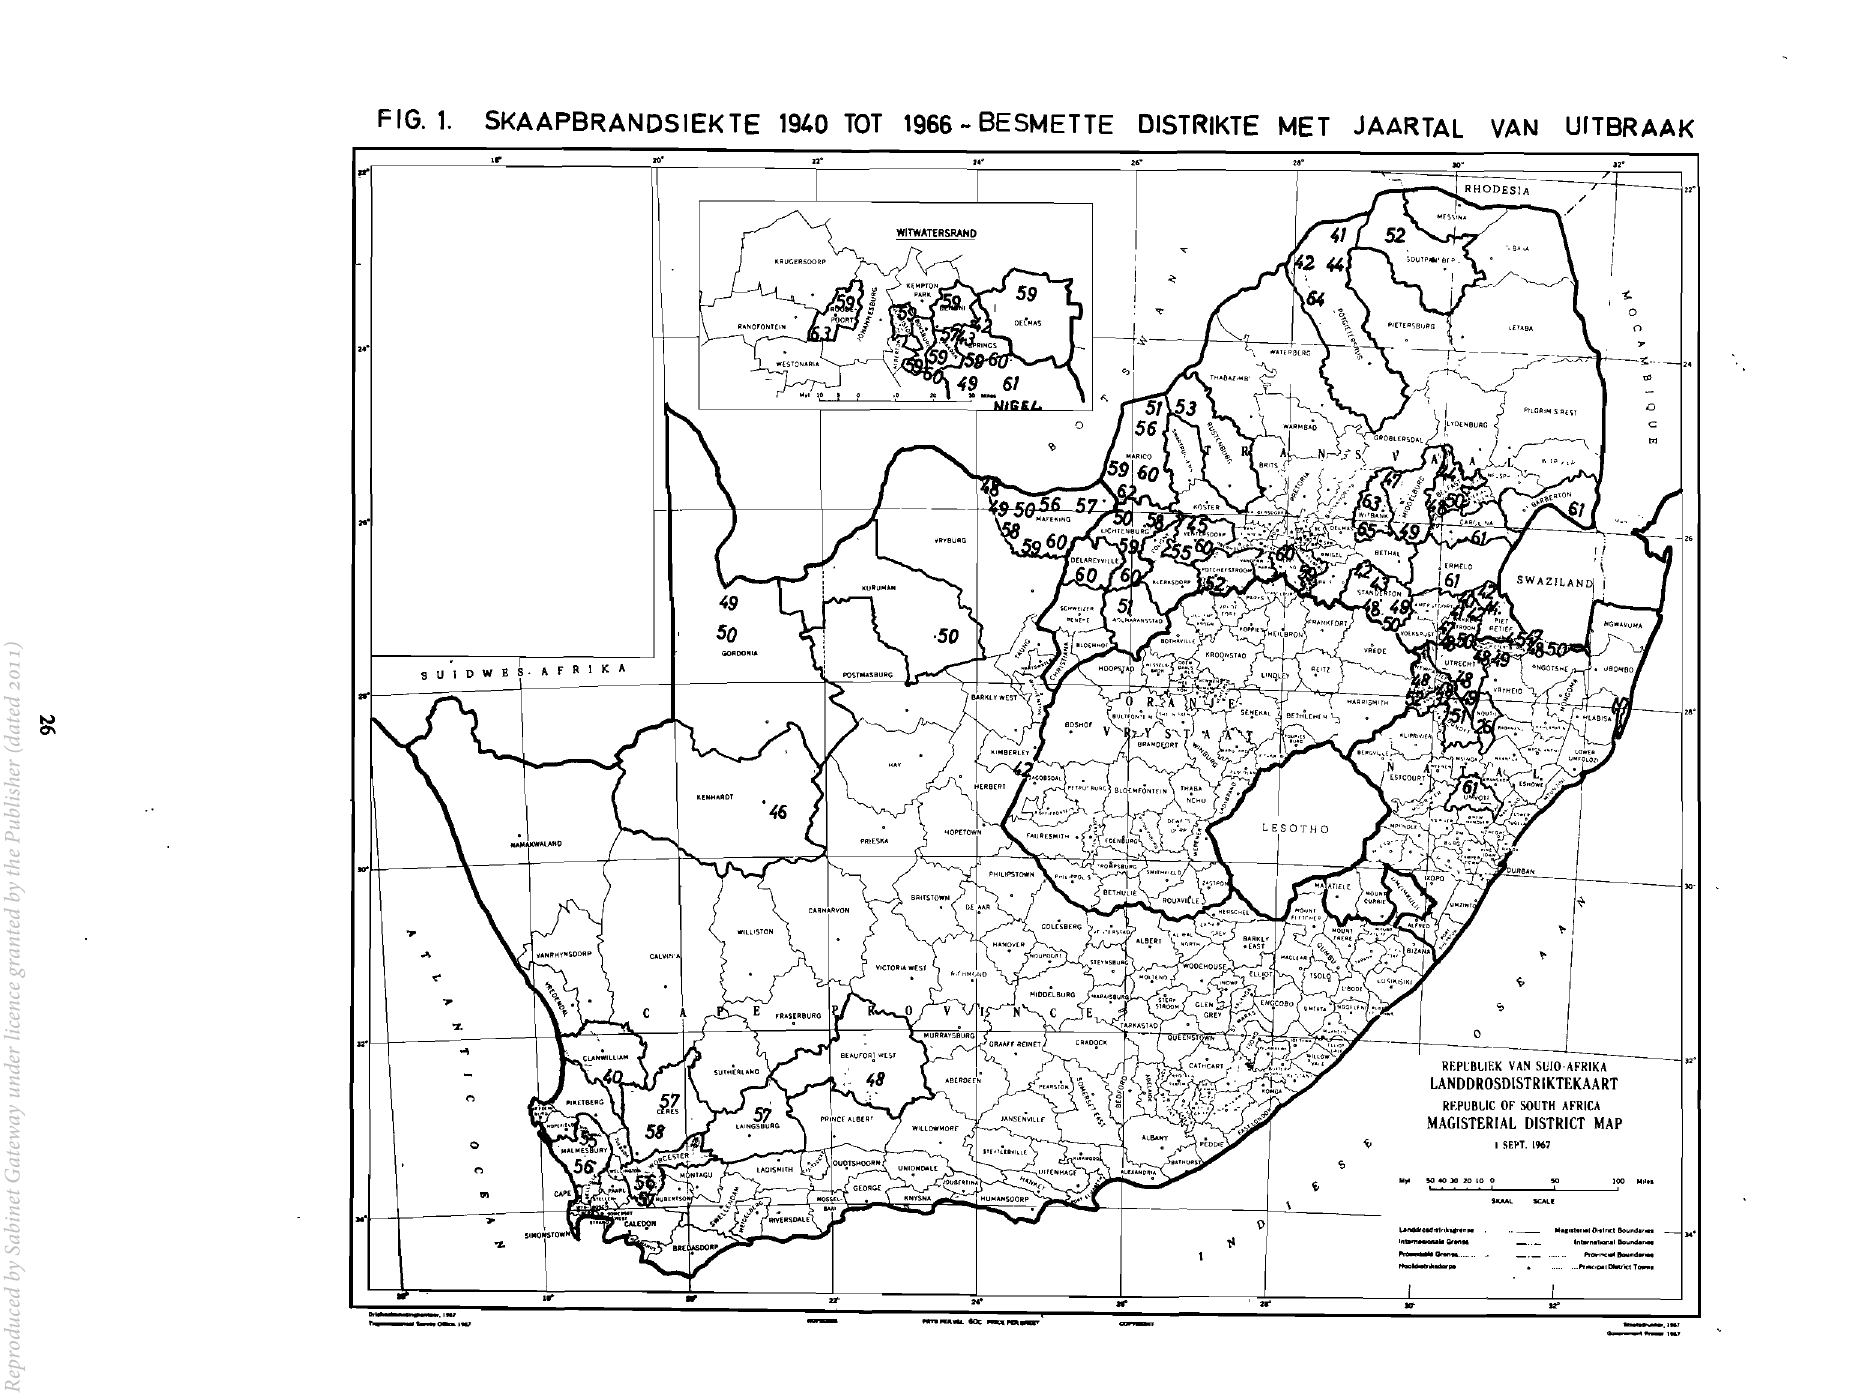
FIG. 1. SKAAPBRANDSIEKTE 1940 TOT 1966 - BESMETTE DISTRIKTE MET JAARTAL VAN